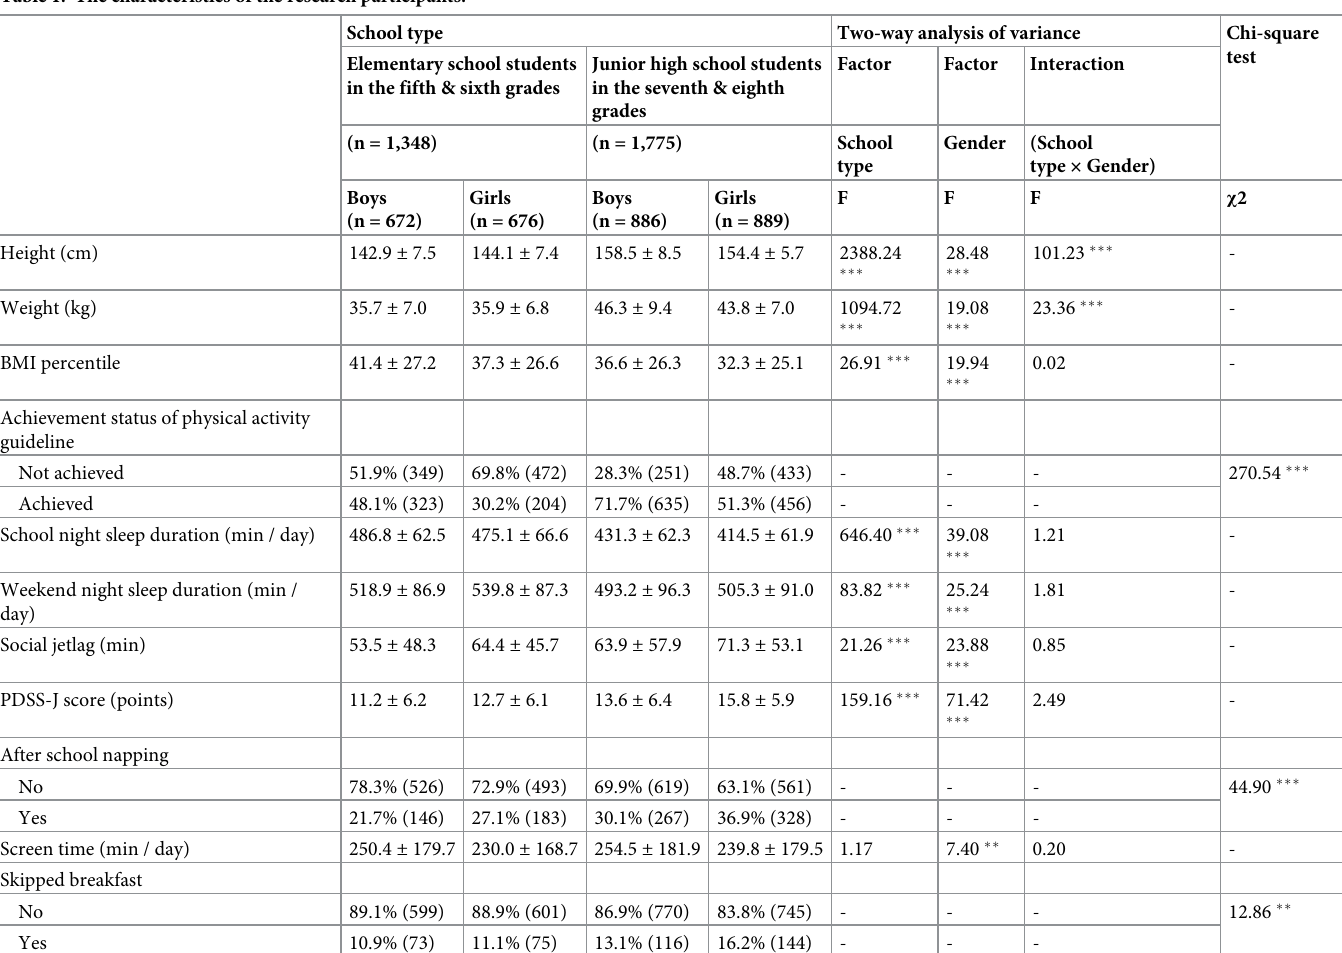
Table 1. The characteristics of the research